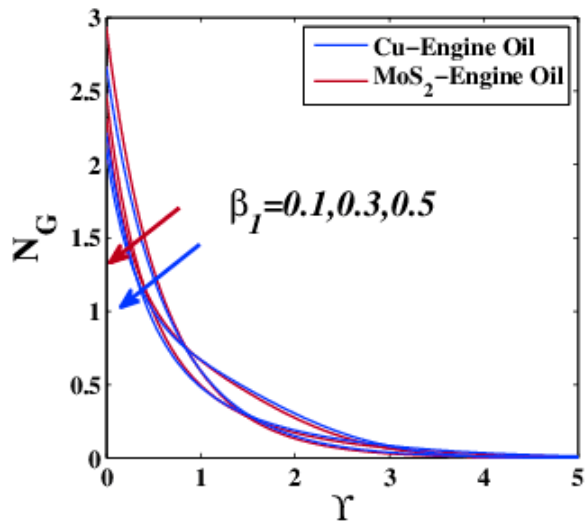
Figure 7. The effect of β 2 on temperature variation θ ( Y ) .